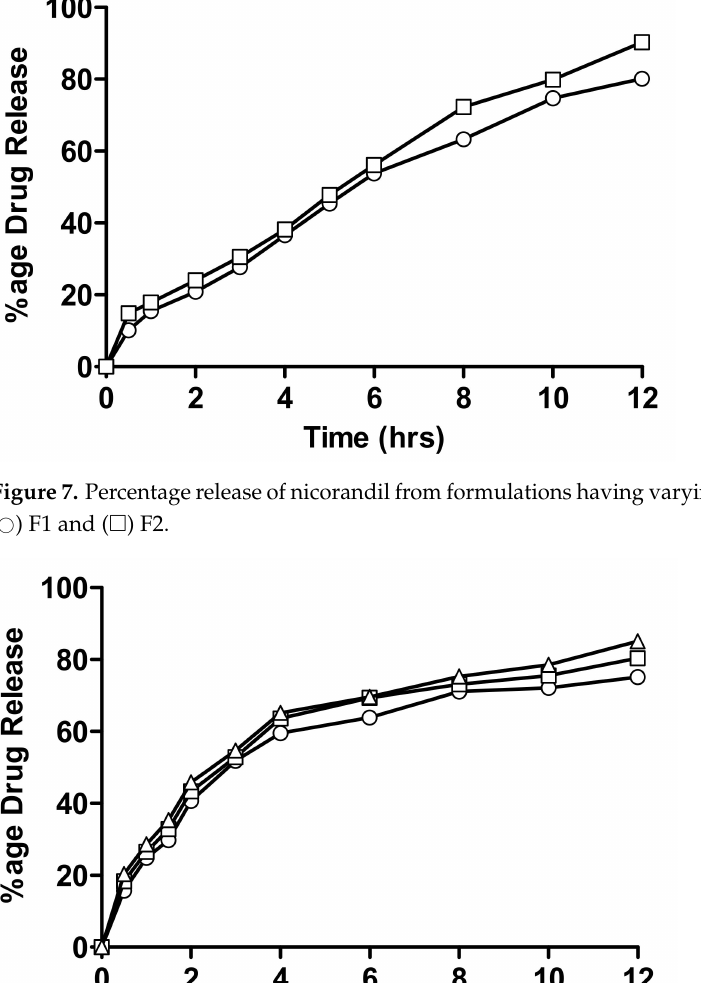
) F6 and ( (cid:3) ) (cid:35)